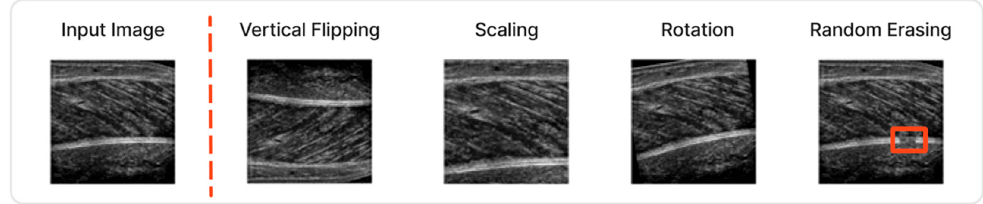
Figure 2. Different image augmentations techniques were utilised during the training of the Atten- tion-UNet.